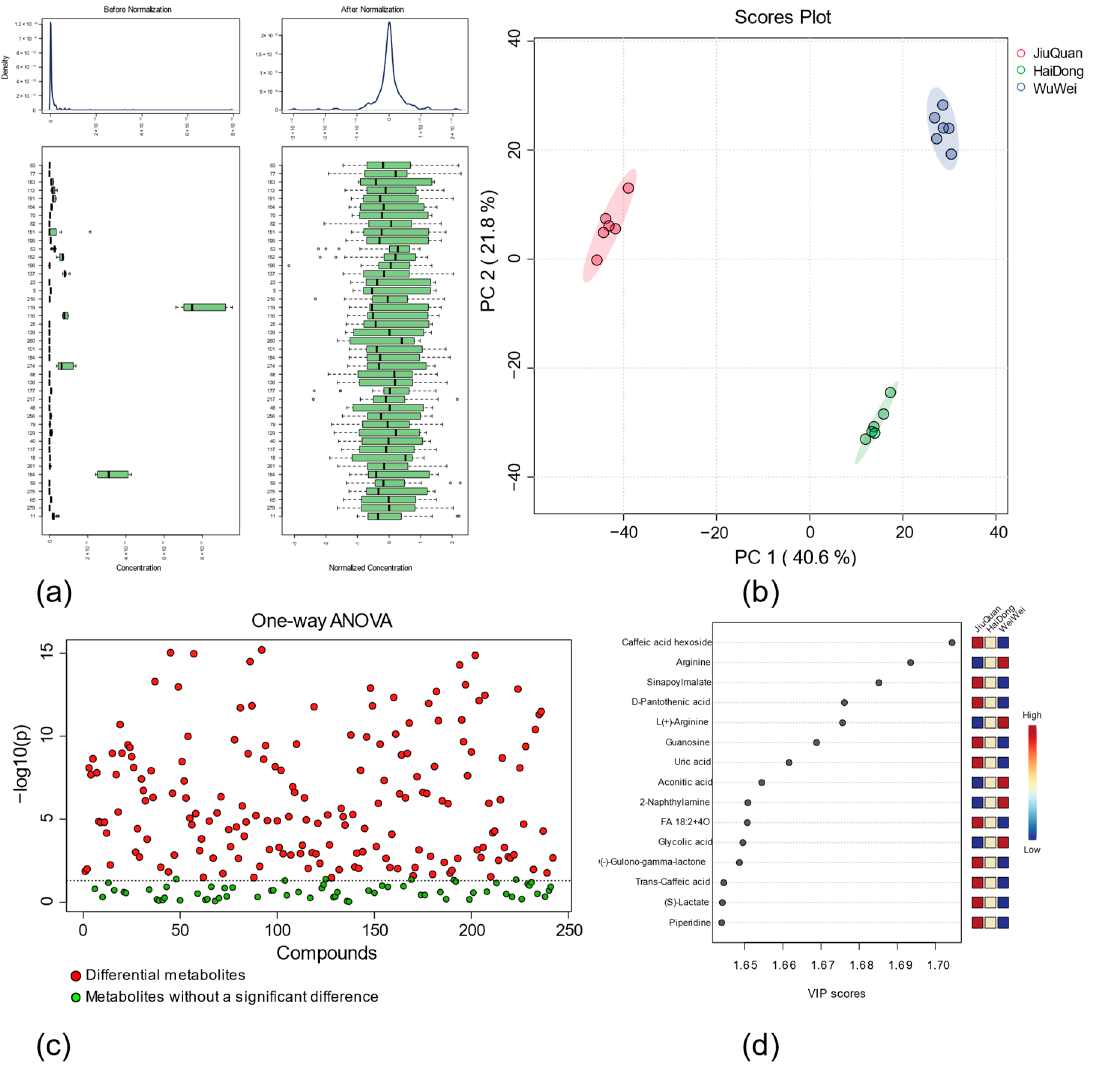
Figure 2. Integrated quality control of Metabolite analysis. ( a ) Metabolite normalization results; ( b ) metabolite principal component analysis, with samples from three regions divided into groups according to the source; ( c ) ANOVA analysis of differential metabolites; ( d ) the top 15 metabolites with VIP values greater than one from the PLS ‐ DA analysis results.